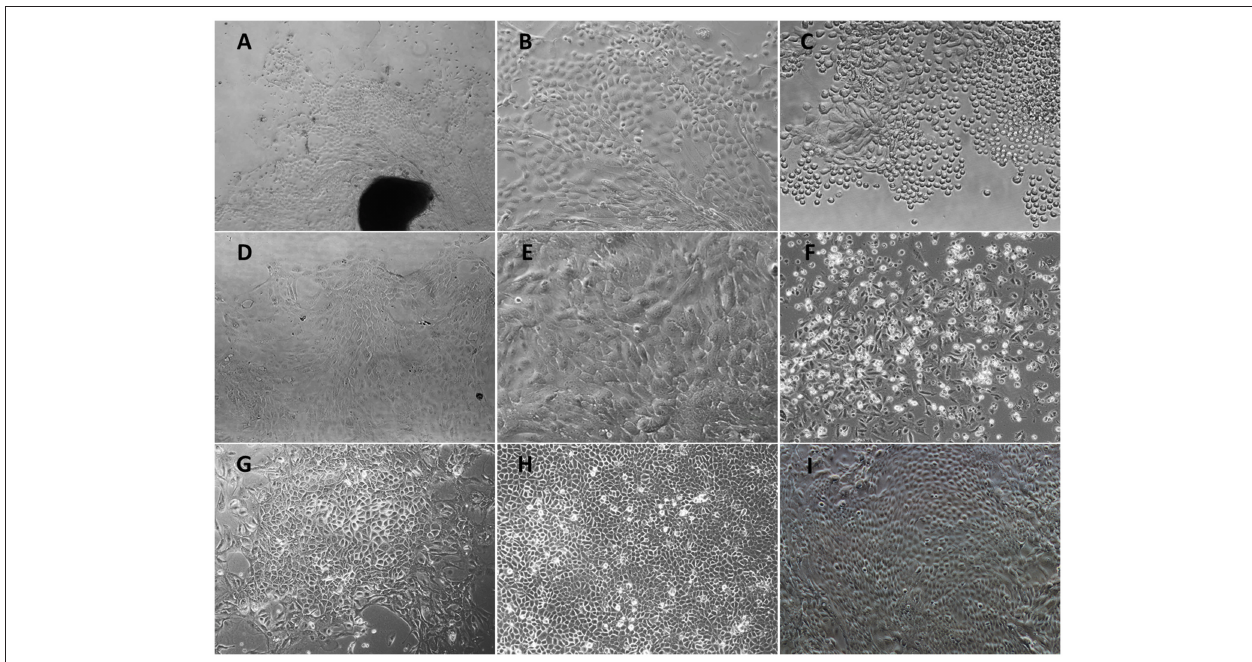
FIGURE 1 | Morphological features of primary POMECs and hTERT-POMECs. (A) Primary tissue culture of POMECs at day 5 ( × 100 magnification). The black and dark area represents the epidermal tissue where POMECs derive from. (B) Morphology of primary POMECs ( × 200 magnification). (C) Subcultivation of primary POMECs by trypsin digestion ( × 200 magnification). (D) Morphology of third passage POMECs ( × 100 magnification). (E) Morphology of ninth passage POMECs ( × 200 magnification). (F) Senescent death of 12th passage POMECs ( × 100 magnification). (G) G418-resistant cell clone ( × 100 magnification). (H,I) Morphology of 35th and 110th passage hTERT-POMECs ( × 100